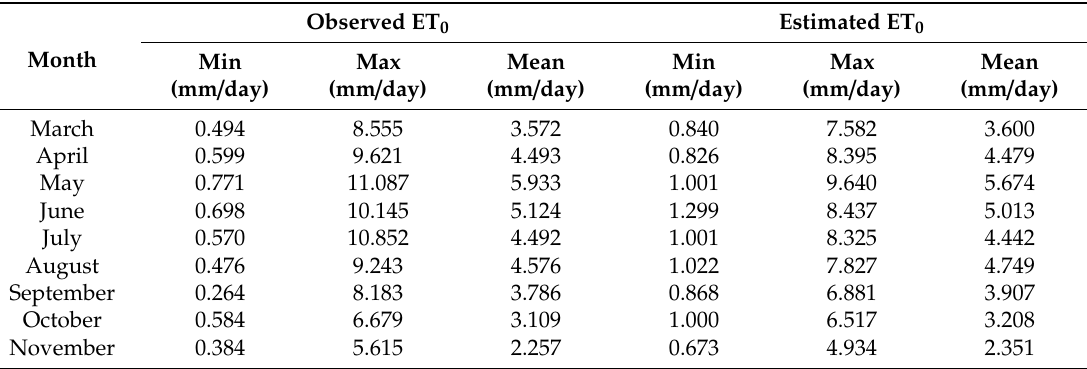
Table 6. Comparison of observed vs. estimated daily ET 0 in the croplands in South Korea, with their min, max, and mean.